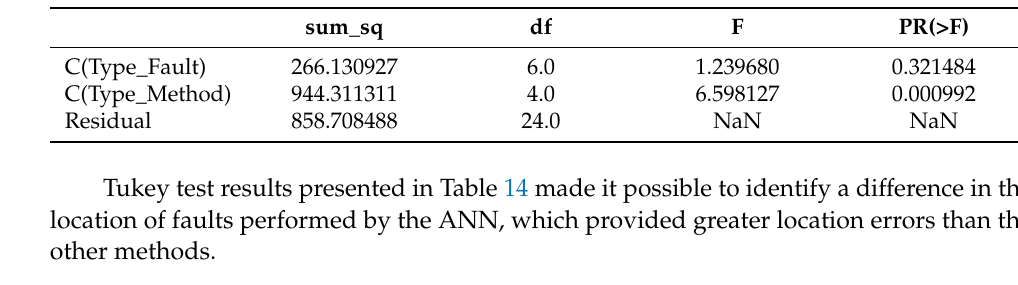
Table 14. Multiple comparisons of means: Tukey HSD, FWER = 0.05—real cases.